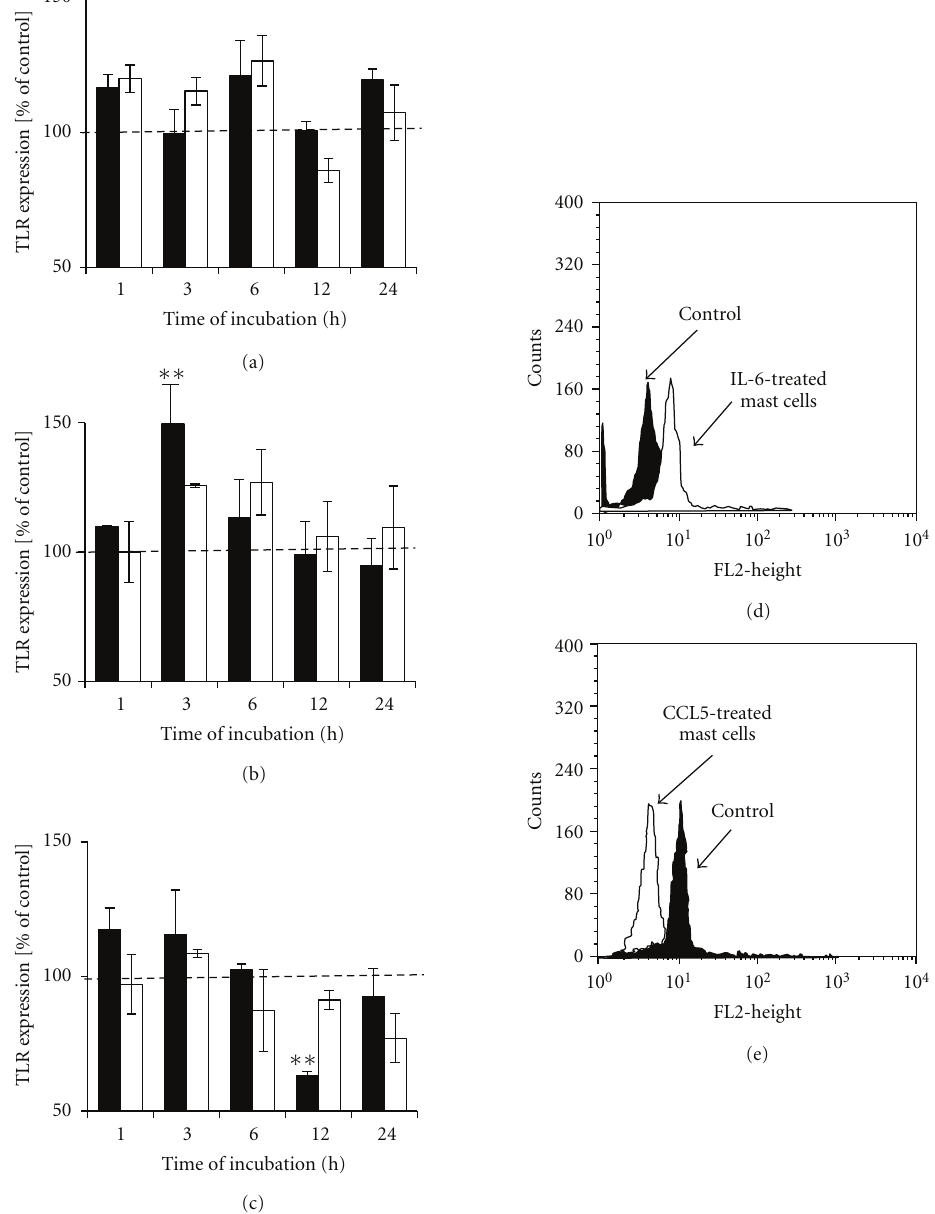
Figure 6: The e ff ect of (a) TNF, (b) IL-6, and (c) CCL5 on TLR4 expression on rat mast cells. Mast cells were incubated with cytokines or cDMEM (control TLR4 expression on unstimulated cells referred to as 100%) for 1,3, 6, 12, or 24 hours. Cytokine concentrations − 1pg/mL (dark bars) and 10 2 pg/mL (bright bars). Results are presented as a percentage of control TLR2 expression. Each point represents the mean ± SEM of 6 independent experiments. ∗∗ P < . 01. (d) Representative flow cytometry histogram showing TLR4 expression on rat mast cells treated with 1 pg/mL IL-6 for 3h. (e) Representative flow cytometry histogram showing TLR4 expression on rat mast cells treated with 1pg/mL CCL5 for 14h. Filled histograms: untreated mast cells (control) and open histograms: IL-6- or CCL5-treated mast